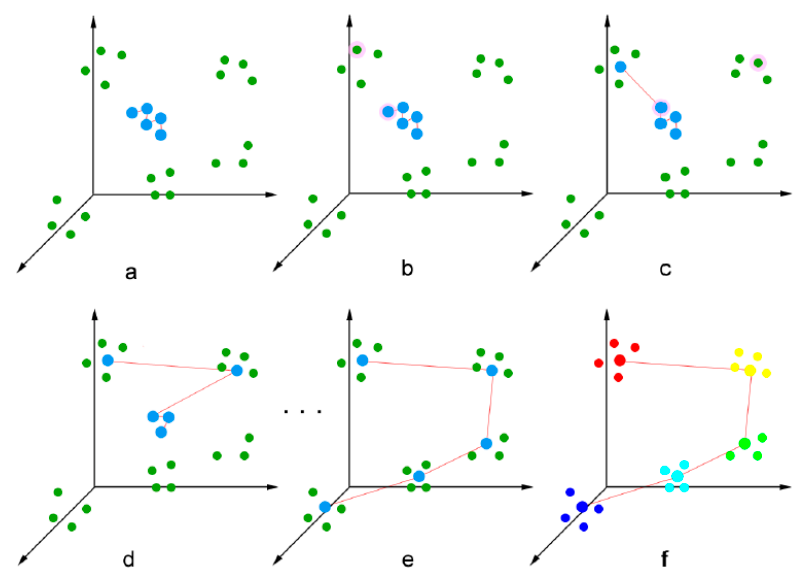
Figure 5. The self-organization process with a single-row structure of the Kohonen layer.